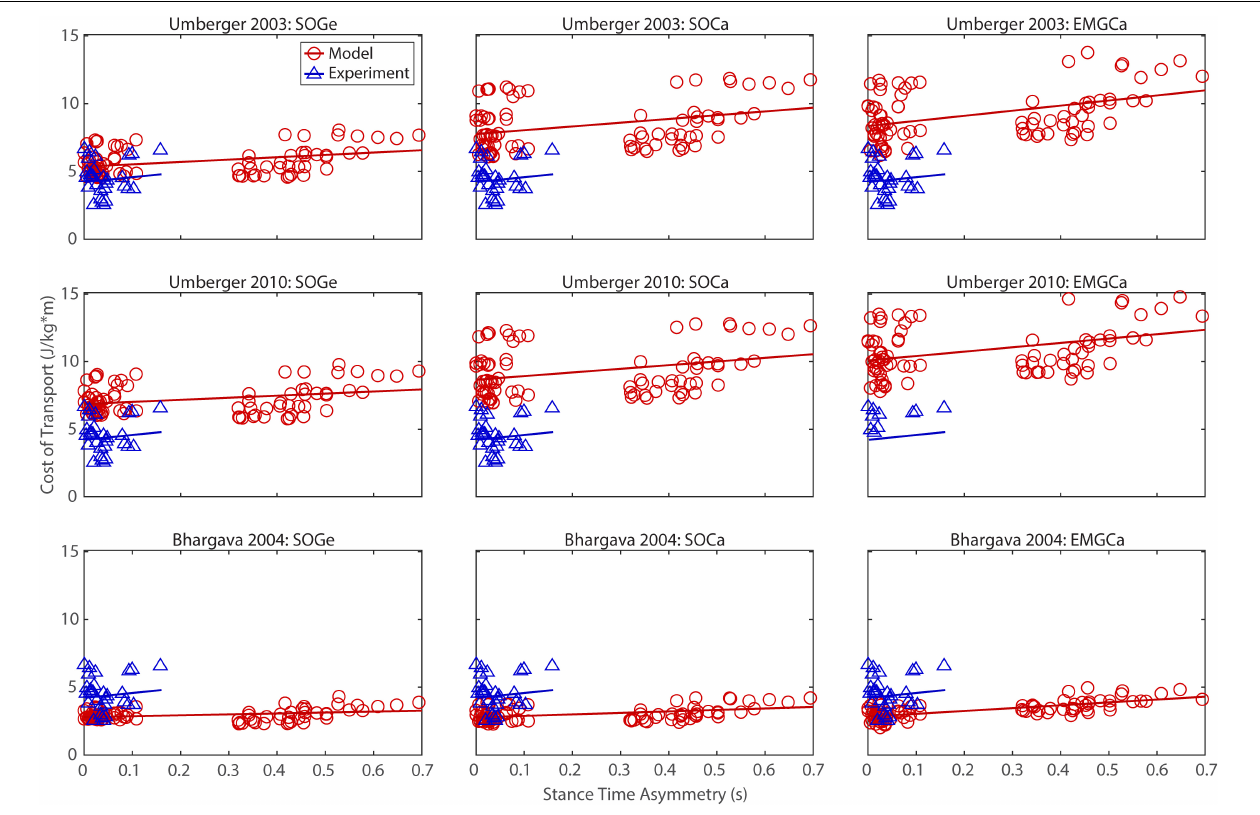
FIGURE 4 | Comparison of model predicted (red circles) and experimentally measured (blue triangles) cost of transport as a function of stance time asymmetry between paretic and non-paretic legs. See Figure 2 caption for additional details.